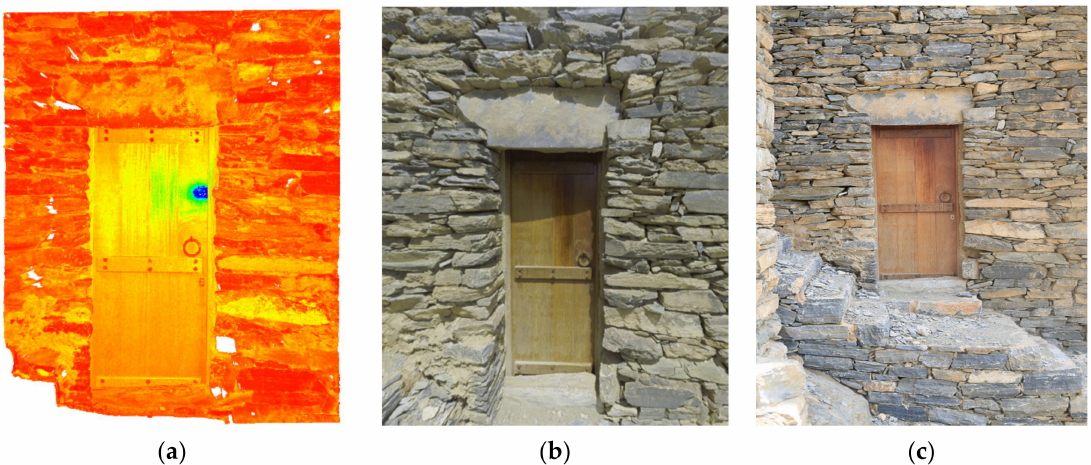
Figure 22. ( a ) DSM of the surface; in white areas no DSM data are available; ( b ) color image using TLS camera; ( c ) indepen- dent image using Canon EOS (12 Mega